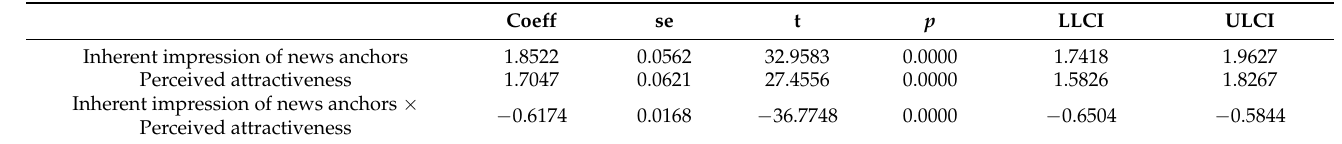
Table 4. Fit results of the moderating effect.